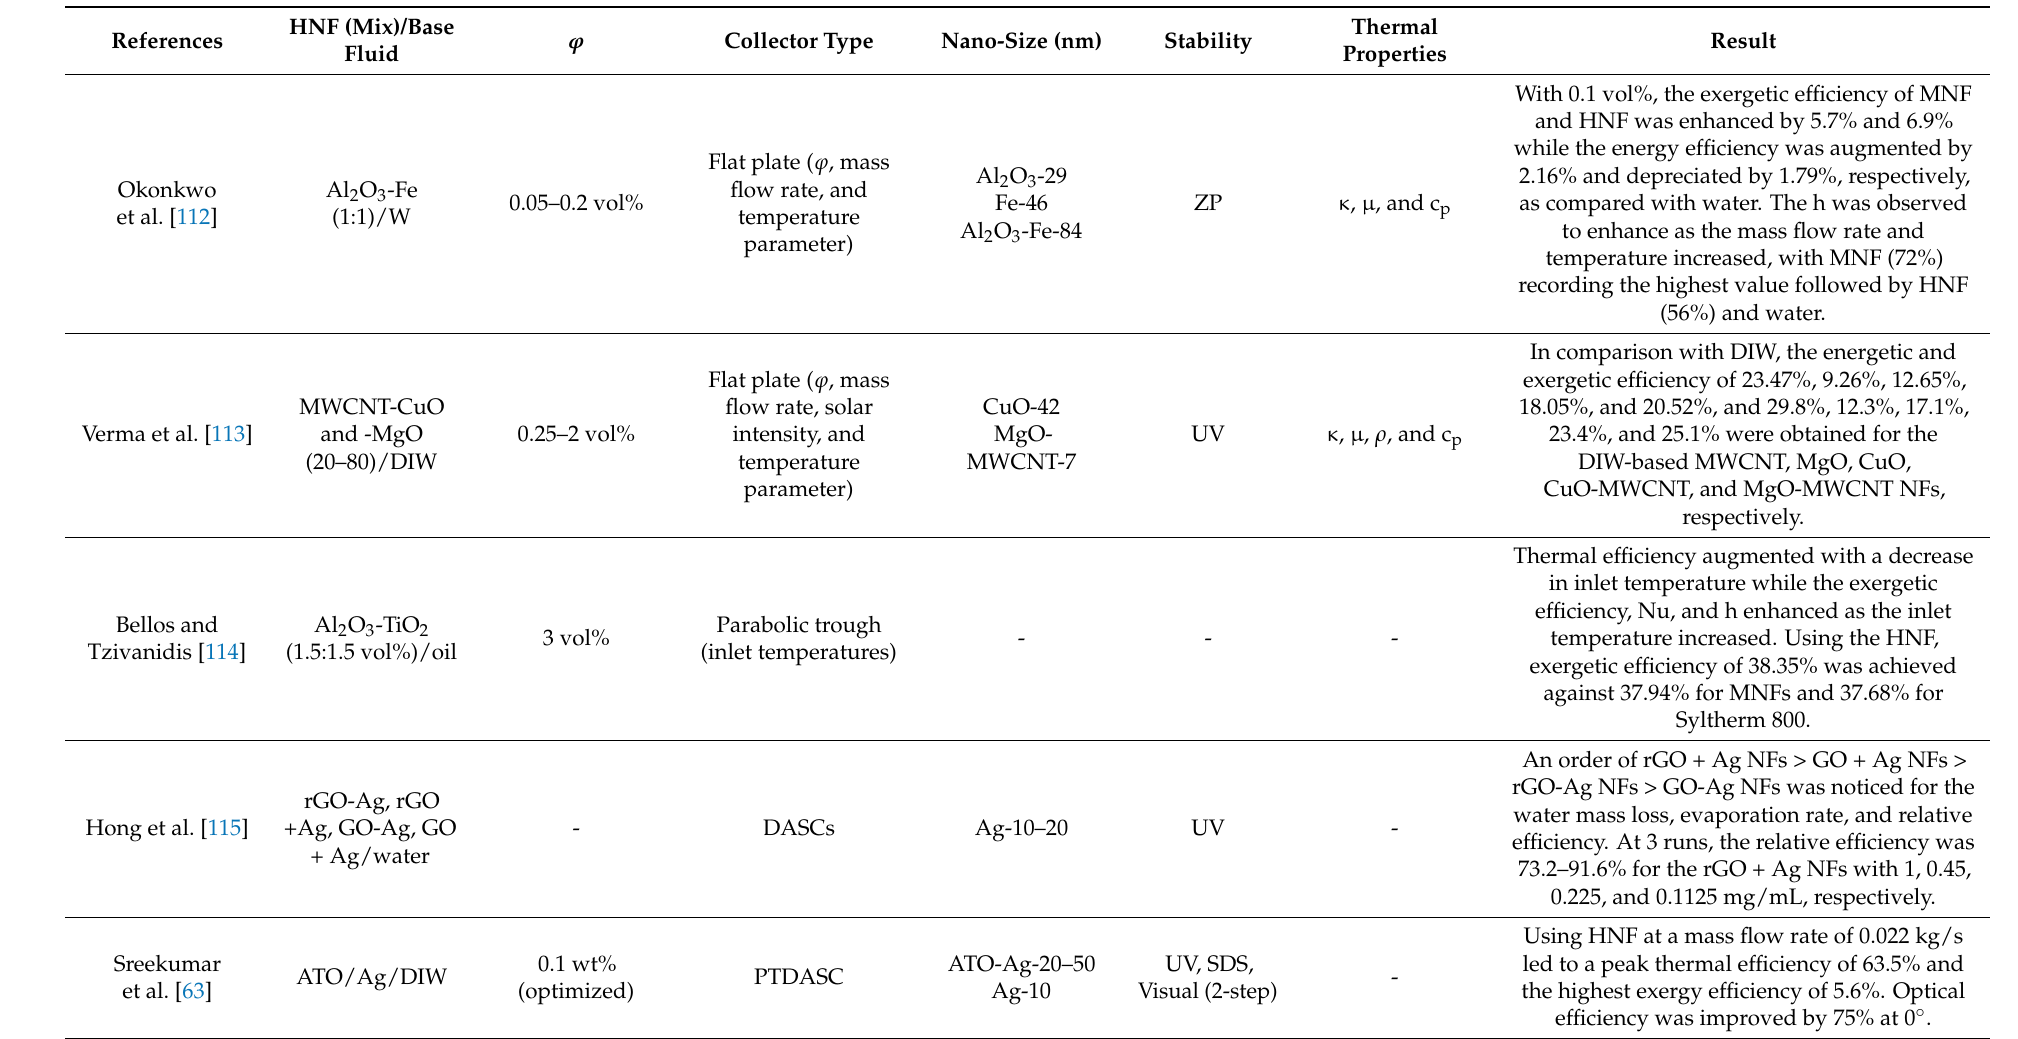
Table 3. Summary of stability tests, thermal properties, and performances of different HNFs, deployed in various solar